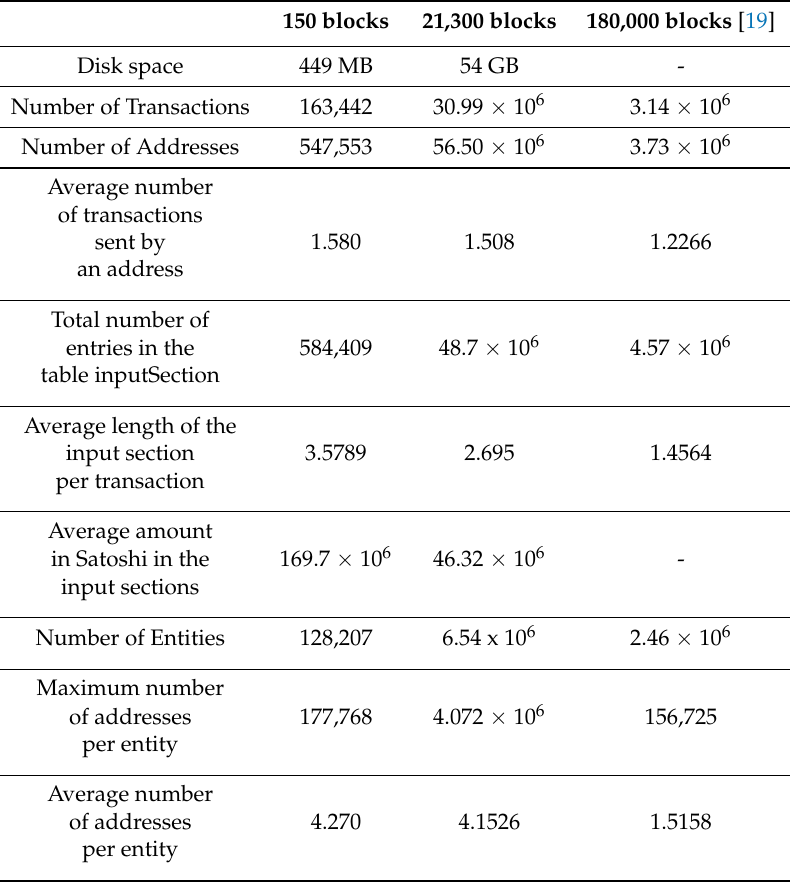
Table 1. Blockchain statistics obtained by querying the database. This table reports the results of the queries applied to the single batch (150 blocks) and to a larger collection of 21,300 blocks (142 batches), starting from the maximum height of 566,874. As a term of comparison, the table reports the results of the same queries for the first 180,000 blocks of the blockchain. For this column, the reported values are computed on the base of findings presented in [19] 150 blocks 21,300